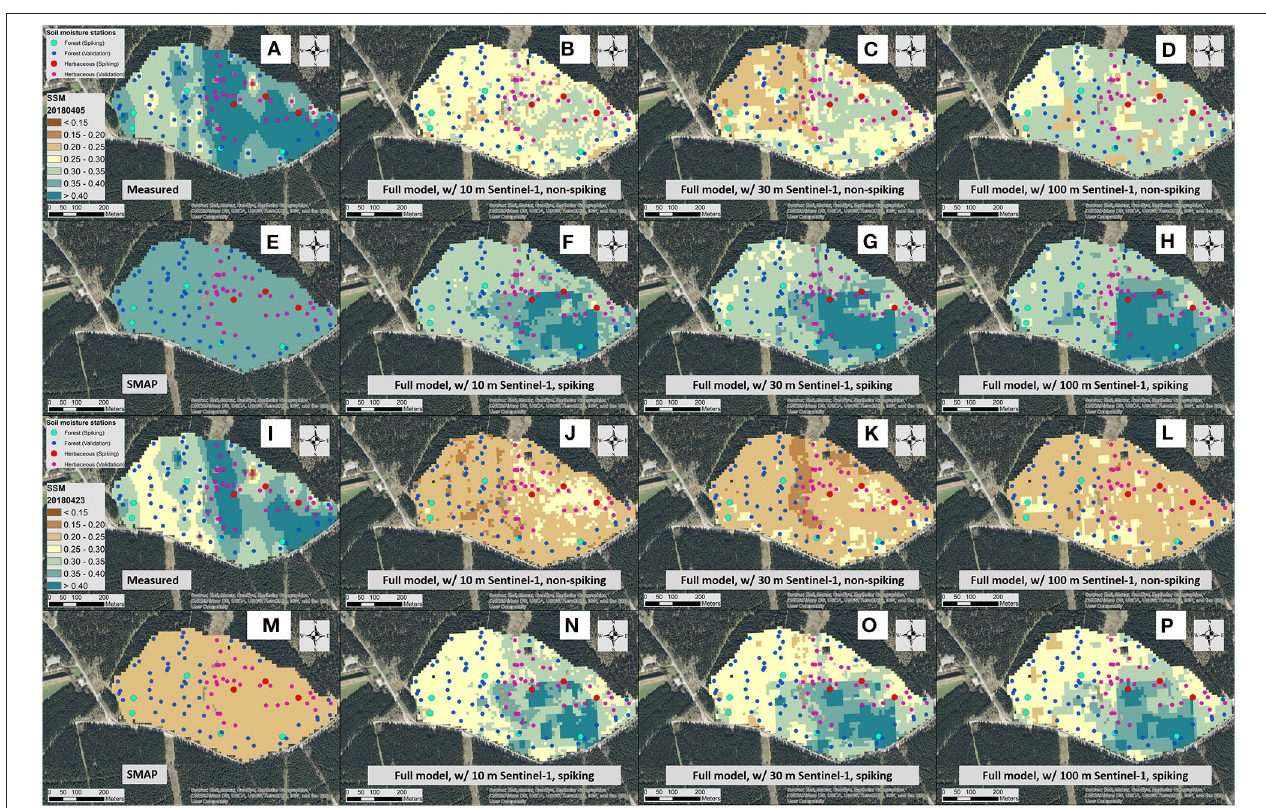
FIGURE 7 | Measured (interpolated soil moisture network measurements using inverse distance weighing, A,I ) vs. predicted surface soil moisture (SSM, m 3 m − 3 ) from the SMAP L3 product (SMAP, E,M ) and quantile random forest (QRF) models on wet (2018/04/05, top) and dry (2018/04/23, bottom) soil moisture conditions across the field-scale TERENO-Wüstebach soil moisture network. The QRF models were established using different input covariates without (non-spiking, B–D,J–L ) and with (spiking, F–H,N–P ) local training datasets and using Sentinel-1 aggregated at 10, 30, and